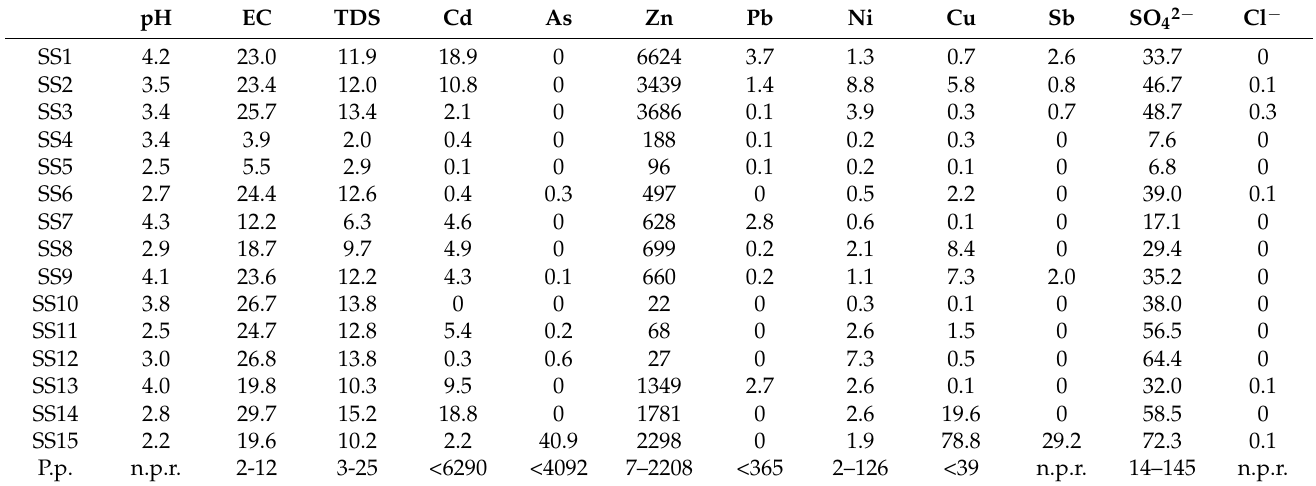
Table 3. Leaching test results for salt efflorescence samples. SS1 to SS15 are different salt samples. EC = electrical conductivity (expressed in mS/cm), TDS = total dissolved solids (expressed in g/kg). Cd, As, Zn, Pb, Ni, Cu and Sb expressed in mg/kg, SO 42 − and Cl − (expressed in g/kg). P.p. = Pollution potential according to WHO guidelines for drinking water [46] expressed as number-fold enriched; n.p.r. = no pollution risk. Elements are presented in decreasing order of pollution